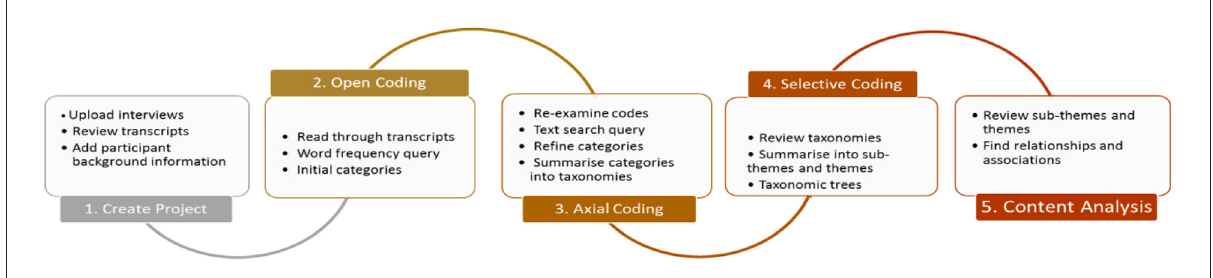
FIGURE1 Steps in the thematic analysis process for the focus group discussions and interviews.